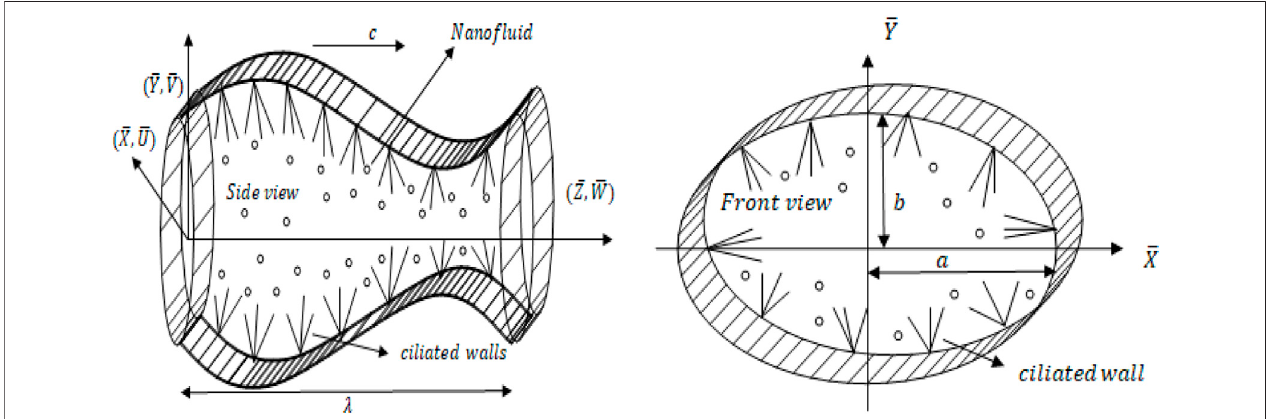
FIGURE 1 | Geometrical model of the fl ow problem referred as [13].